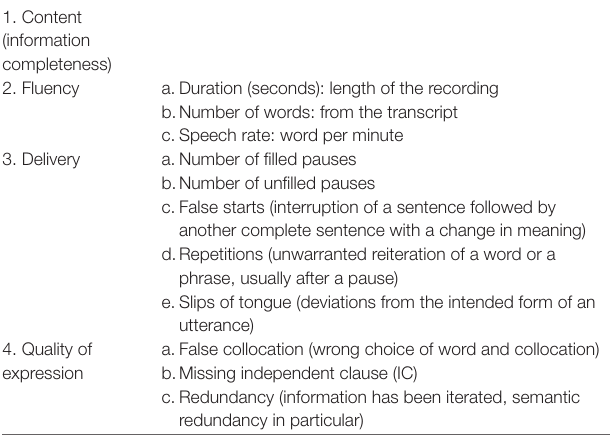
TABLE 5 | Demographic and language profile of subjects (mean and